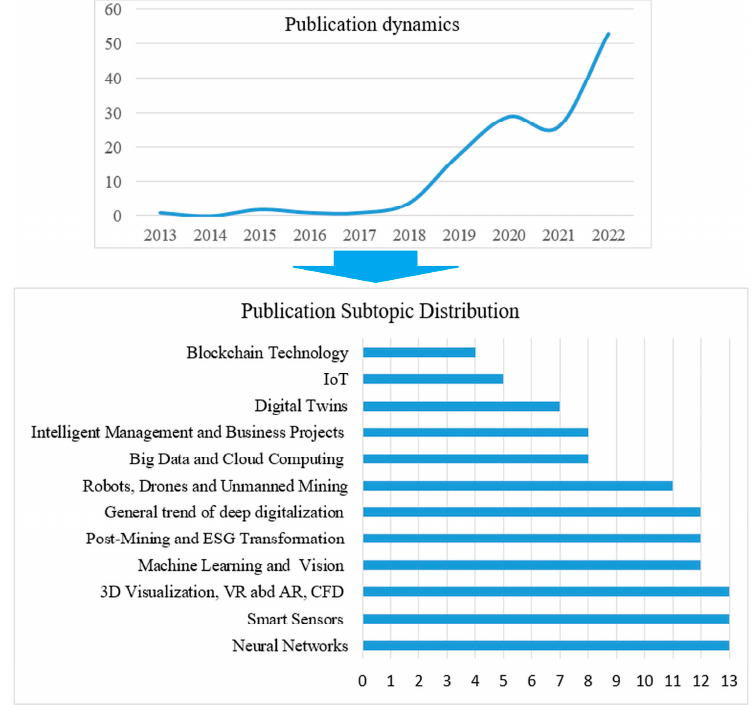
Figure 2. Distribution of scientific publications in the area of Mining 4.0 by years and subtopics.